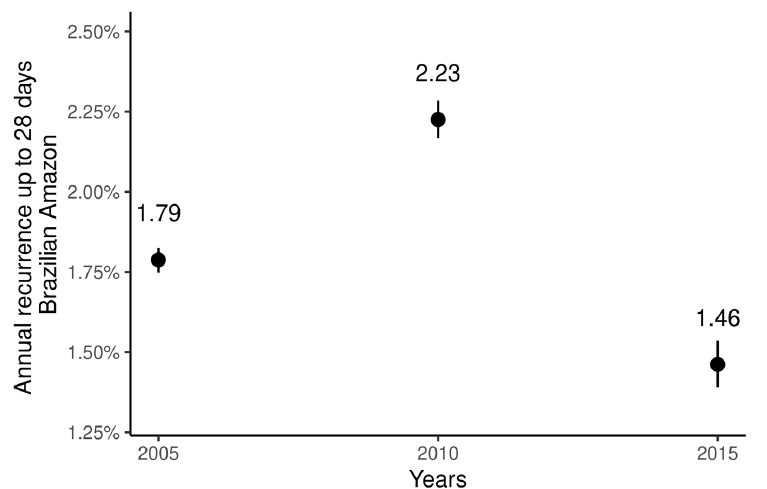
Figure 2. Proportion of short-time recurrences in the Brazilian Amazon in 2005, 2010, and 2015. Bars represent 95% confidence intervals.